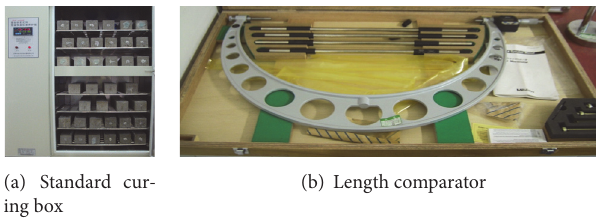
Figure 3: Devices for drying shrinkage of specimen.